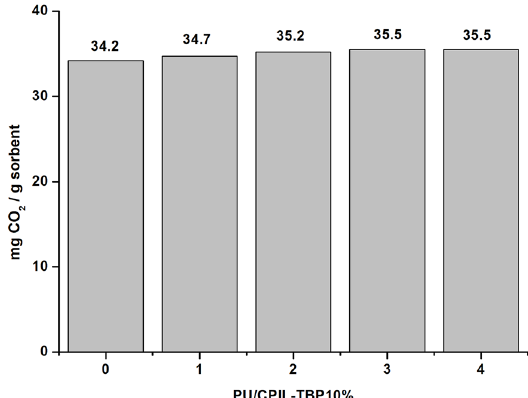
sorption/desorption cycles. 2